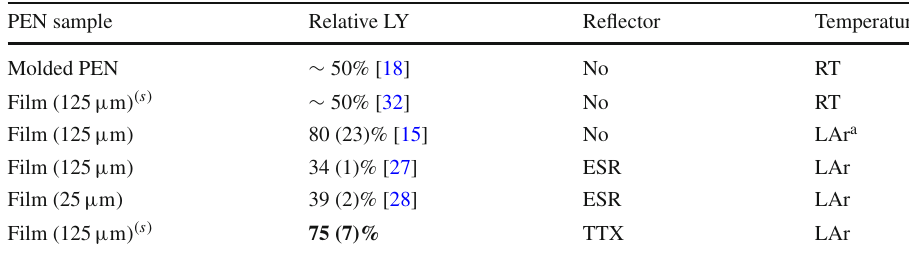
PEN sample Relative LY Reflector Temperature Molded PEN ∼ 50%